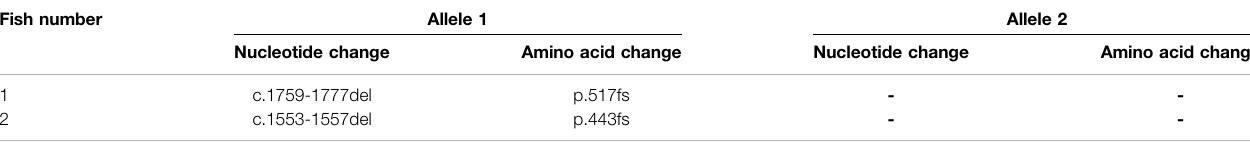
TABLE 1 | Heterozygous fi sh with ngly1 mutant alleles. Fish